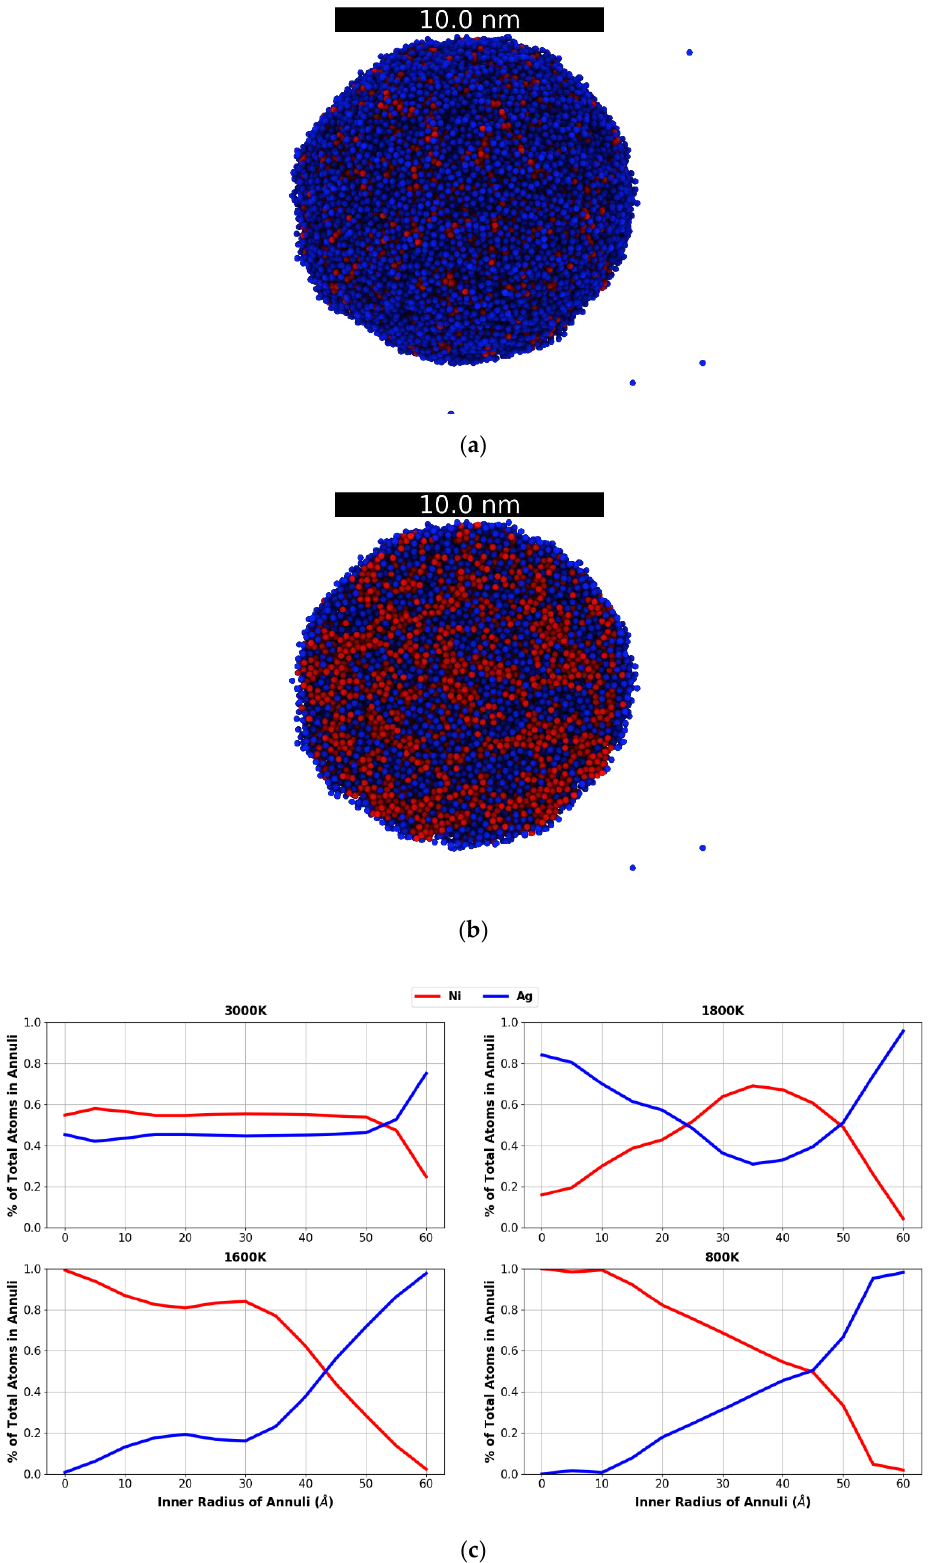
Figure 7. ( a ) NiAg droplet at 2200 K showing preferential movement of Ag to the surface, ( b ) slice of NiAg droplet at 2200 K, and ( c ) atomic concentration distribution analysis for the droplets at 3000 K, 1800 K, 1600 K, and 800 K. Color code: Ni, red and Ag,